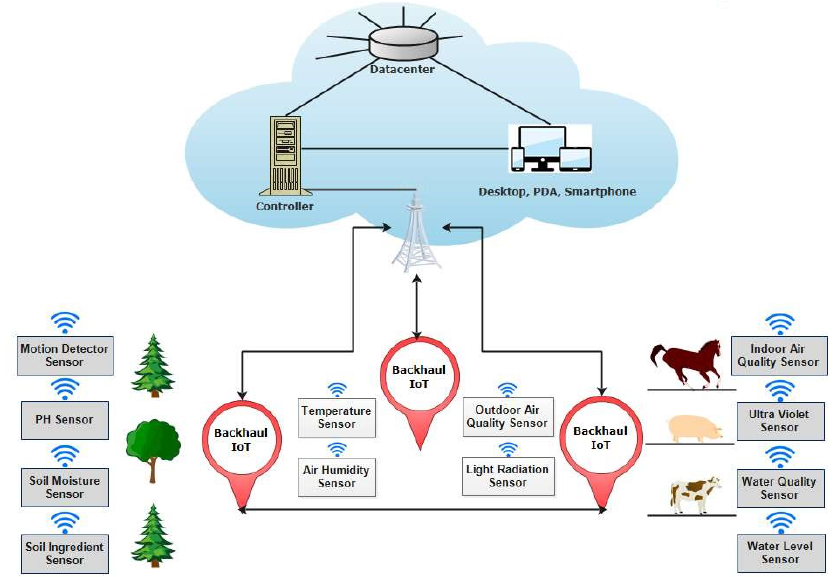
Figure 5. An illustration of the common IoT-based smart agriculture topology.